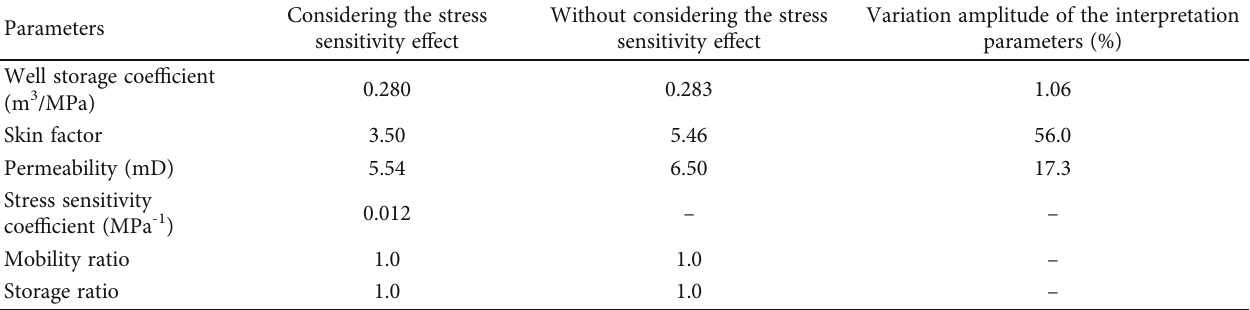
Table 2: Comparison of interpretation results with and without considering the stress sensitivity e ff